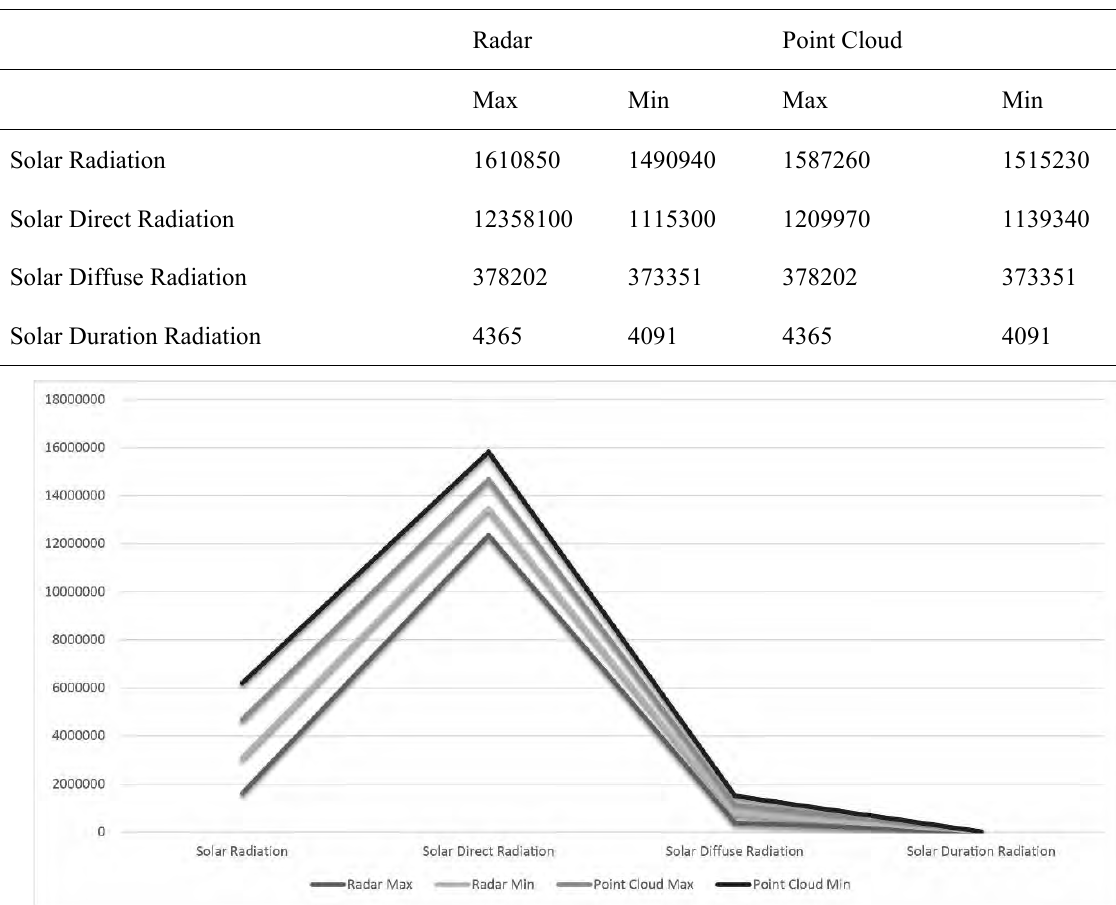
Figure 9 - Comparison of annual radiation in the point cloud and radar